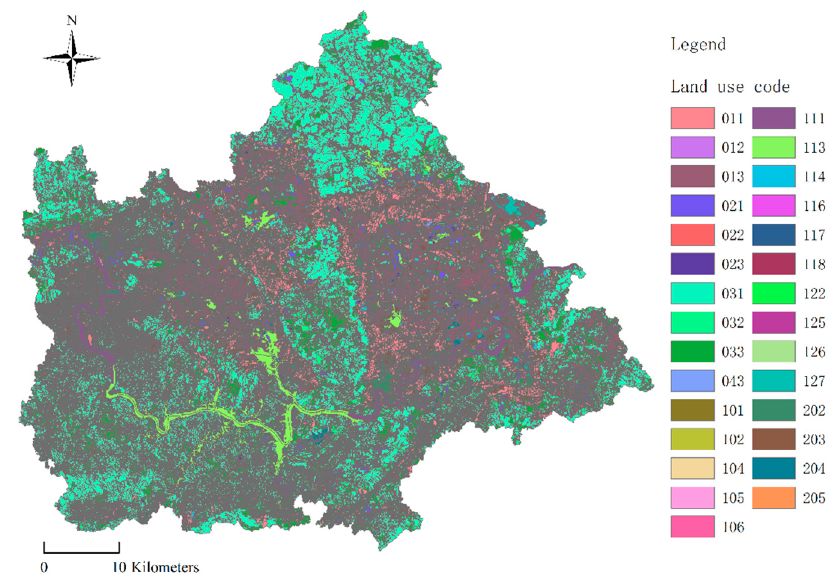
Figure 4. Land use dataset of Zhenlong Town.